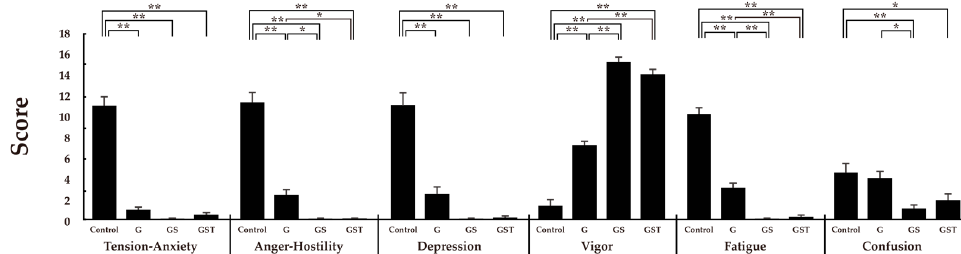
Figure 5. Comparison of Profile of Mood States (POMS) subscale scores for the four rooftop images. Control: no vegetation with concrete floor; type G: grass vegetation; type GS: grass-shrubs vegetation; type GST: grass-shrubs-trees vegetation; n = 15, mean ± SE; *, p < 0.05; **, p < 0.01.